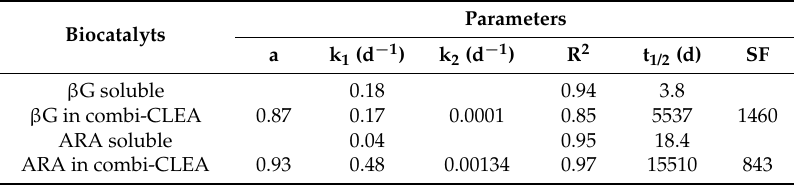
Table 1. Inactivation parameters of soluble and immobilized β G and ARA in Muscat wine at 16 ◦ C. t 1/2 : half-life; SF: stability factor, as defined in the text; t 1/2 for combi-CLEAs were determined by extrapolation of the experimental data according to the corresponding models of